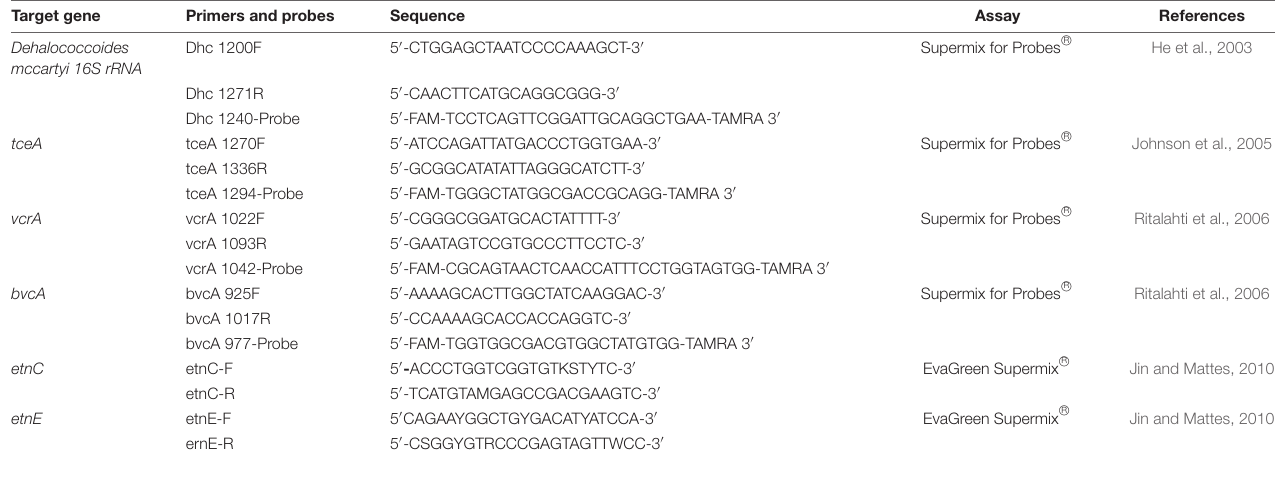
TABLE 3 | Primers and probes used for ddPCR gene quantifications. Target